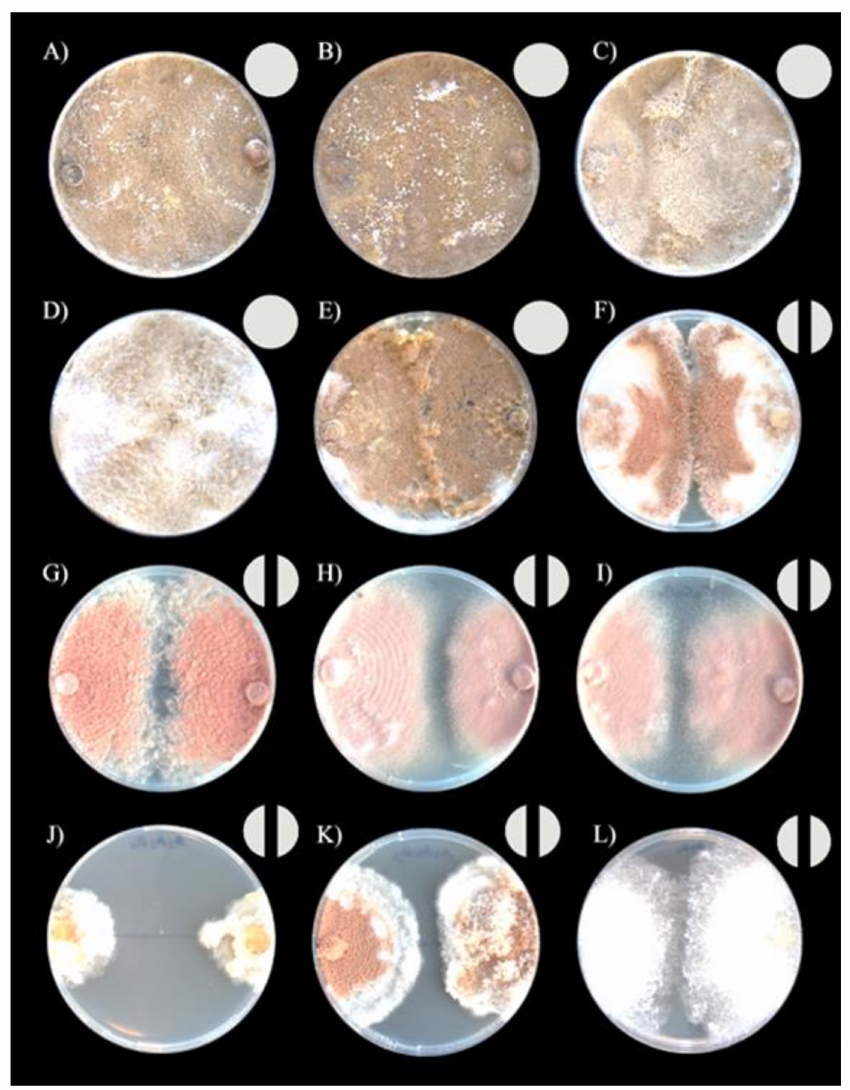
Figure 3. Intraclonal confrontation bioassays between Escovopsis strains. ( A ) Escovopsis sp. from At . colombica , intermingling; ( B ) Escovopsis sp. from At . cephalotes , intermingling and ( C ) At . sexdens , intermingling; ( D ) Escovopsis sp. from Par . cornetzi , intermingling; ( E ) Escovopsis sp. from Myc . zeteki , intermingling; ( F ) Escovopsis sp. from T . sp10 , inhibition; ( G ) Escovopsis sp. from C . sp. colony, inhibition; ( H ) Escovopsis sp. from C . longiscapus colony, inhibition; ( I ) Escovopsis sp. from C . muelleri colony, inhibition; ( J ) Escovopsis sp. from Ap . auriculatum colony, inhibition; ( K ) Escovopsis from Ap. pilosum colony, inhibition and ( L ) Escovopsis sp. from Ap . collare colony, inhibition. Each photo shows in the top right the symbol of the interaction type that represents